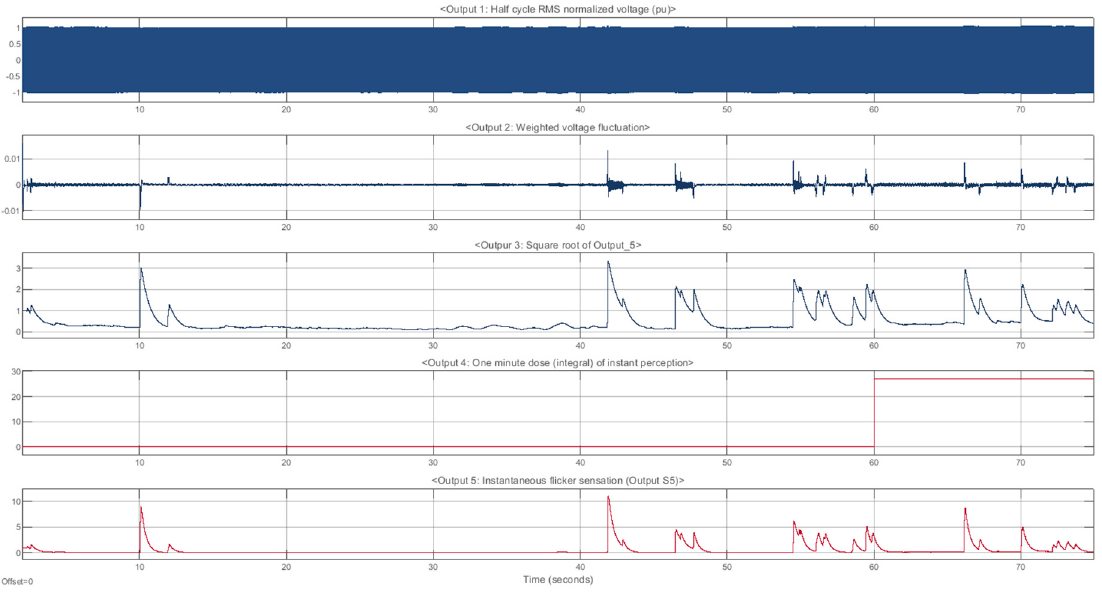
Figure 8. Digital flickermeter [28] output for the simulation of the Matlab Simulink model shown in Figure 7.